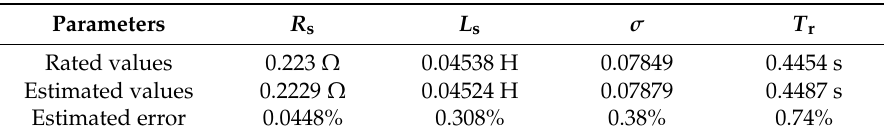
Table 3. Identification values of the IM using the offline RLS method at steady